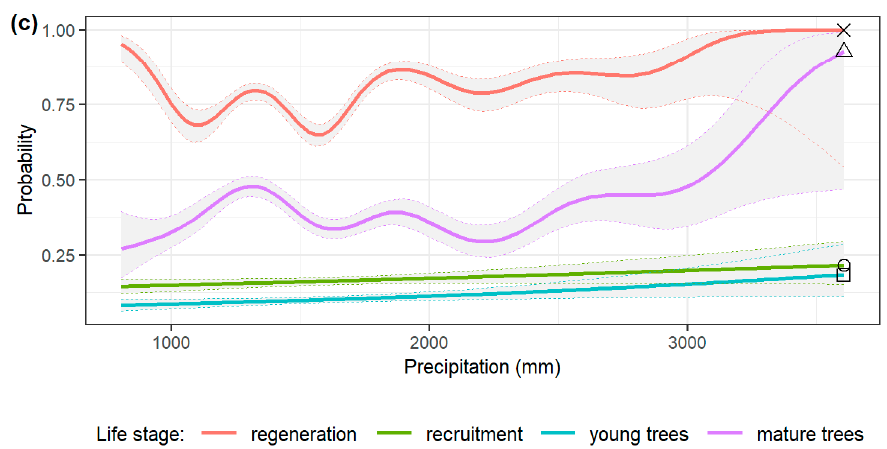
Figure 3. Elevation ( a ), temperature ( b ) and precipitation ( c ) response curves derived with GAM models per life stages of the European beech; the optimums are highlighted by marks related to the life stage.